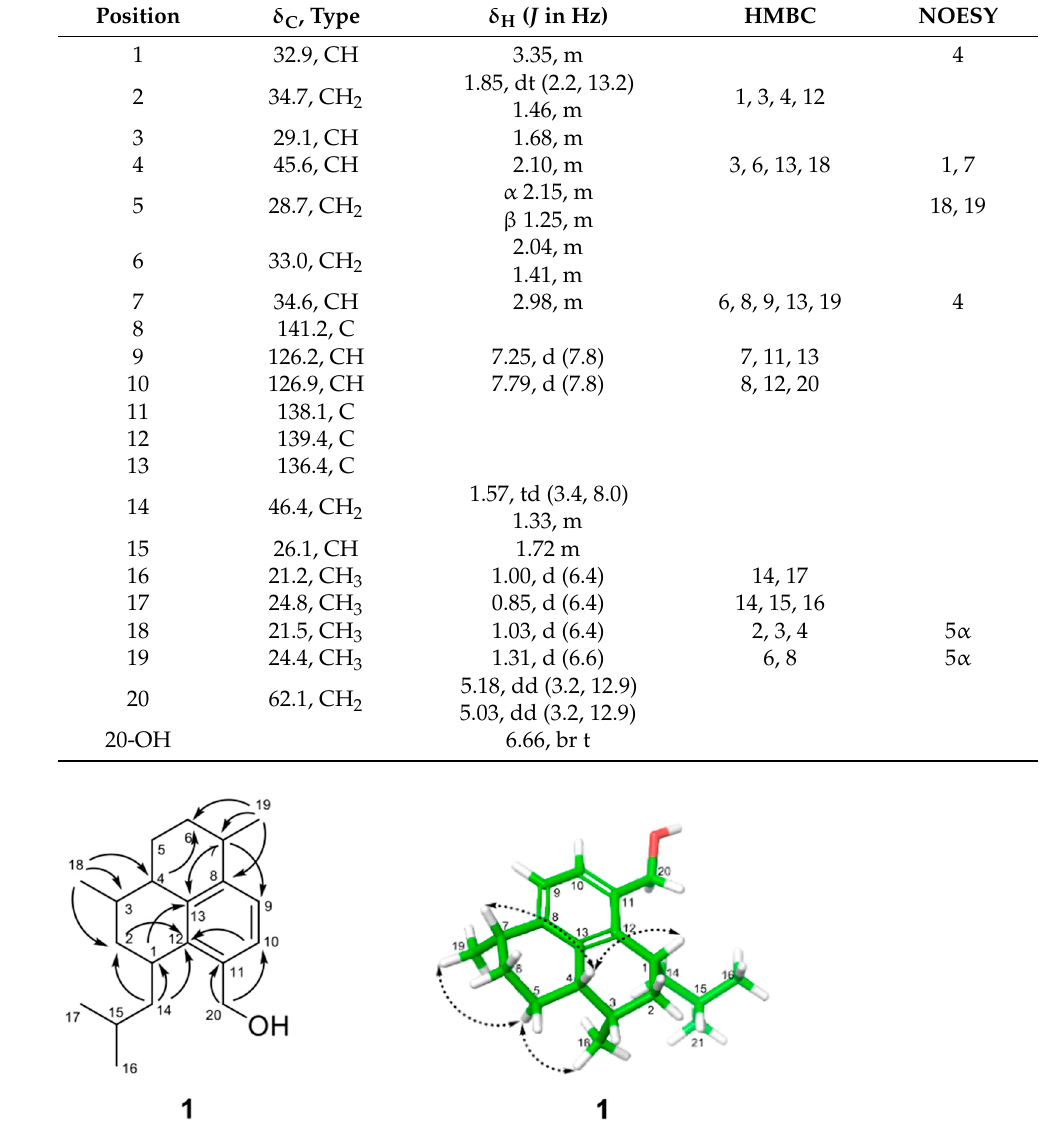
Figure 2. Key HMBC ( ) and NOESY ( ) correlations for 1 . The energy-minimized 3D struc- ture was obtained by Macromodel (Version 12.5, Schrodinger LLC) program. Table 1. NMR spectroscopic data (400 MHz, pyridine- d 5 ) for Compound 1 .